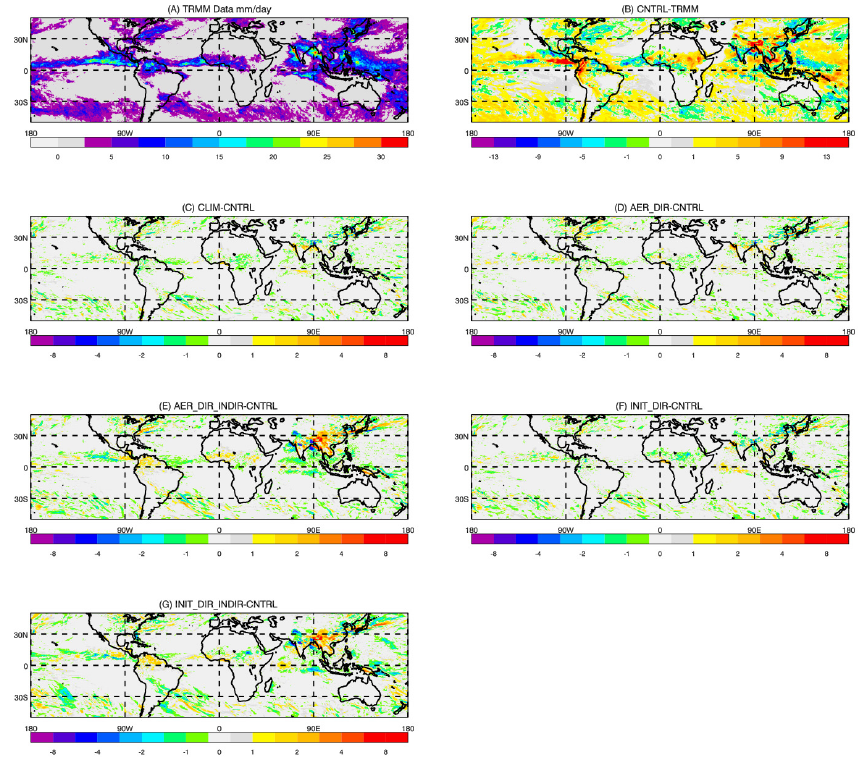
Fig. 16. Impact of aerosol on model precipitation rate (mmday − 1 ) at T + 120: (a) TRMM observations, (b) CNTRL error, (c) CLIM-CNTRL, (d) AER_DIR-CNRTL, (e) AER_DIR_INDIR-CNRTL, (f) INIT_DIR-CNRTL, (g) INIT_DIR_INDIR-CNRTL. Note the different scale used in (c–g)